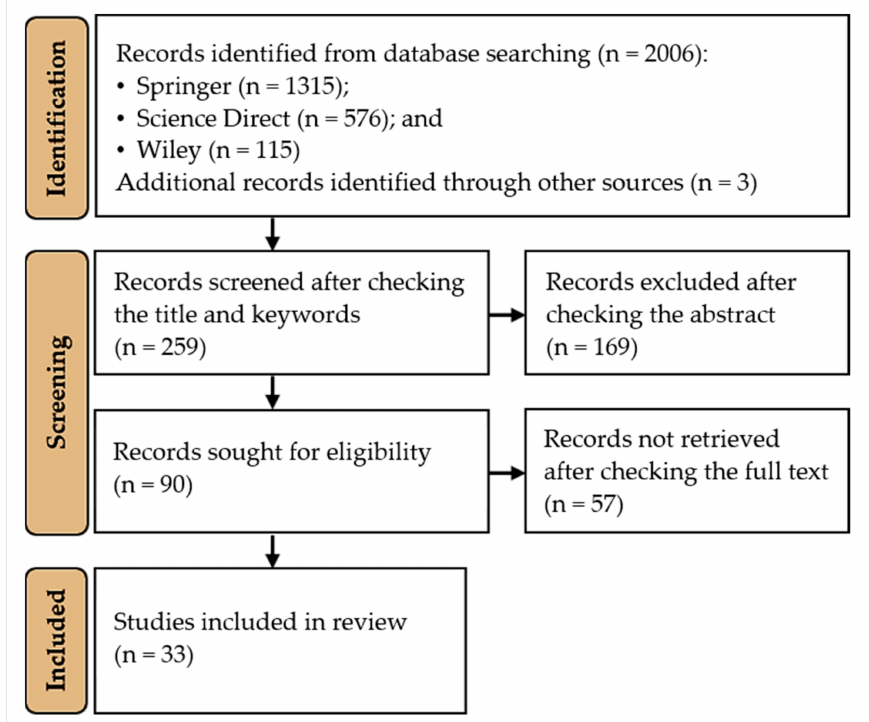
Figure 1. Summary of the search strategy for seaweed callus induction based on